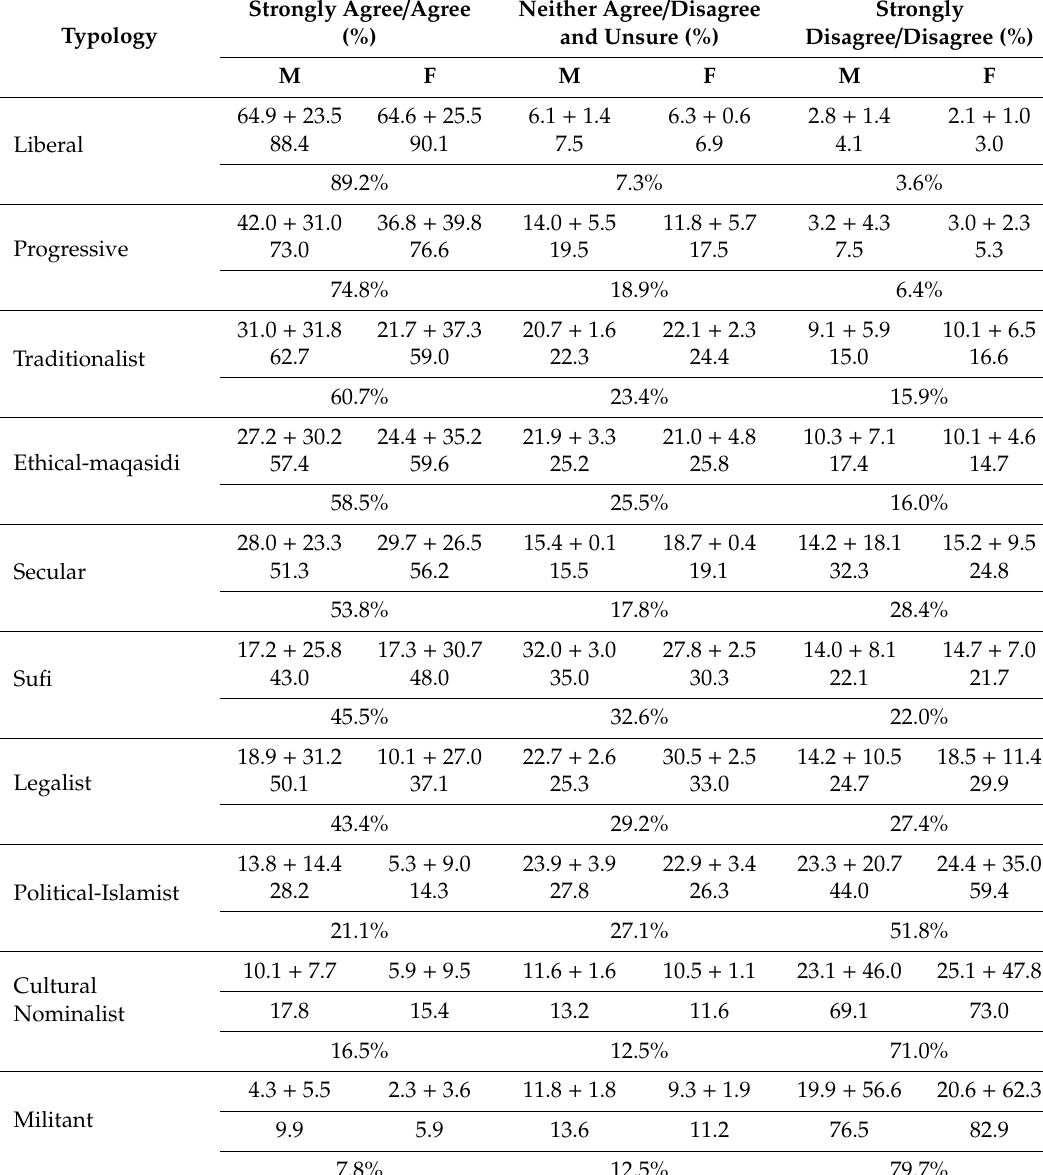
Table 2. Typologies by